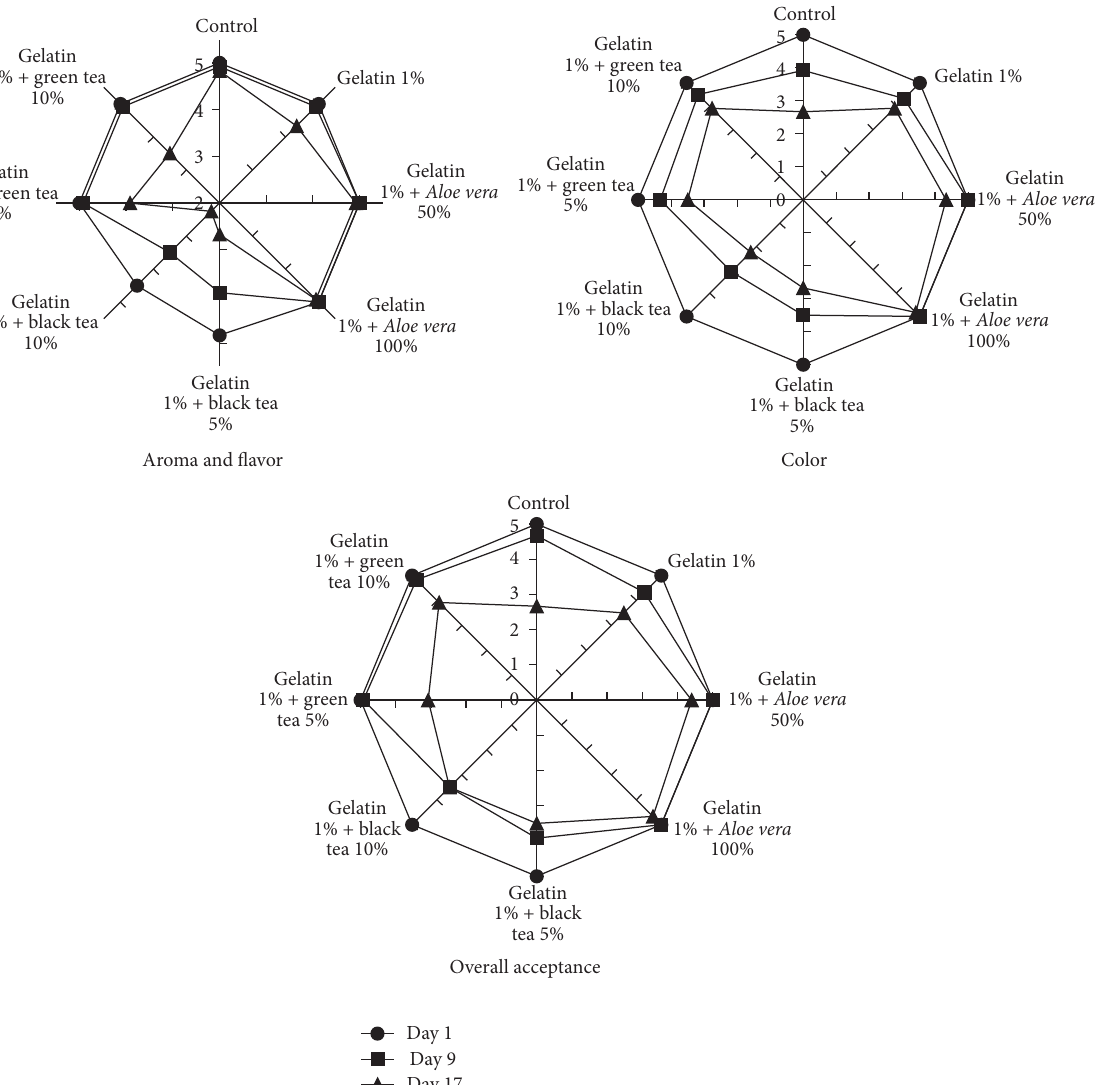
Figure 4: Sensory attributes of fresh-cut oranges on days 1, 9, and 17. Scoring system of color, aroma, flavor, and overall acceptance from extremely dislike (1) to extremely like